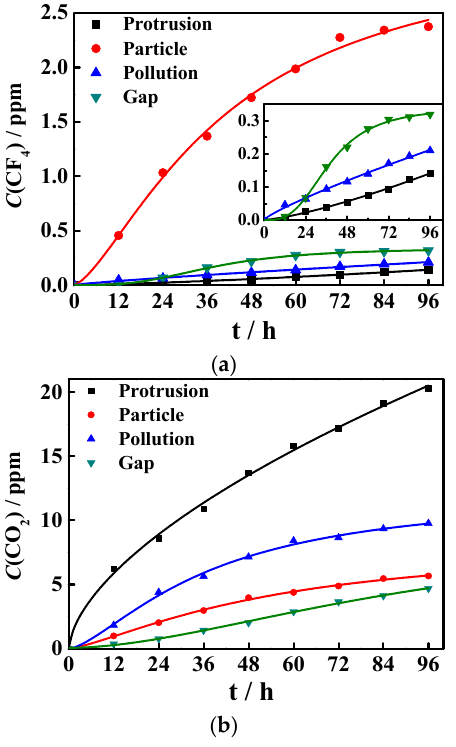
Figure 5. Change curves of the concentrations of CF 4 and CO 2 with time: ( a ) CF 4 ; and ( b ) CO 2 .